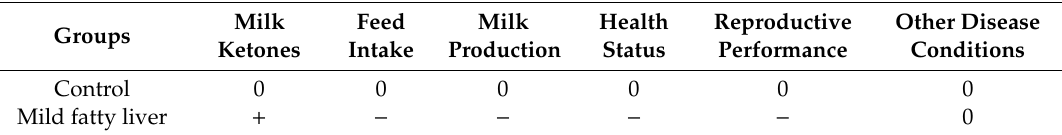
Table 1. Clinical observations of control and mild fatty liver cows.